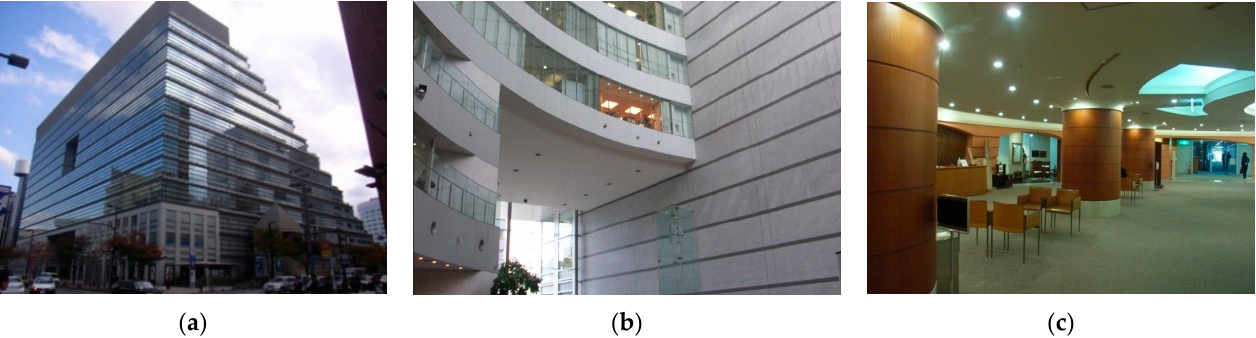
Figure 5. Prefekturalna Hala Mi ę dzynarodowa “Asian CrossRoad Over the Sea”: ( a ) Elewacja pó ł nocna; ( b ) Wewn ę trzne foyer and ( c ) Wn ę trze w cz ęś ci administracyjnej, photograph by B. Majerska-Pa ł ubicka.